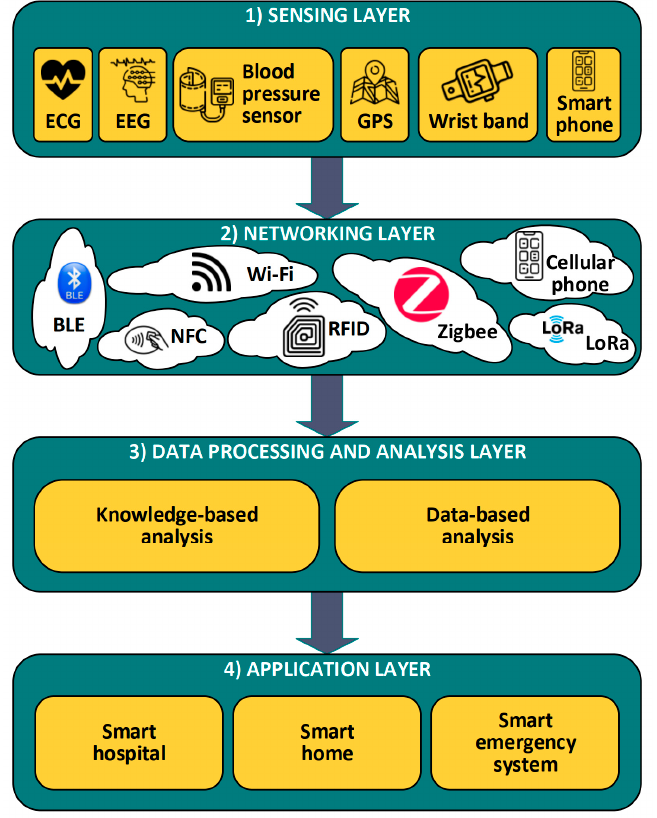
Figure 3. Layered architecture of IoT solution (modified from [60]).